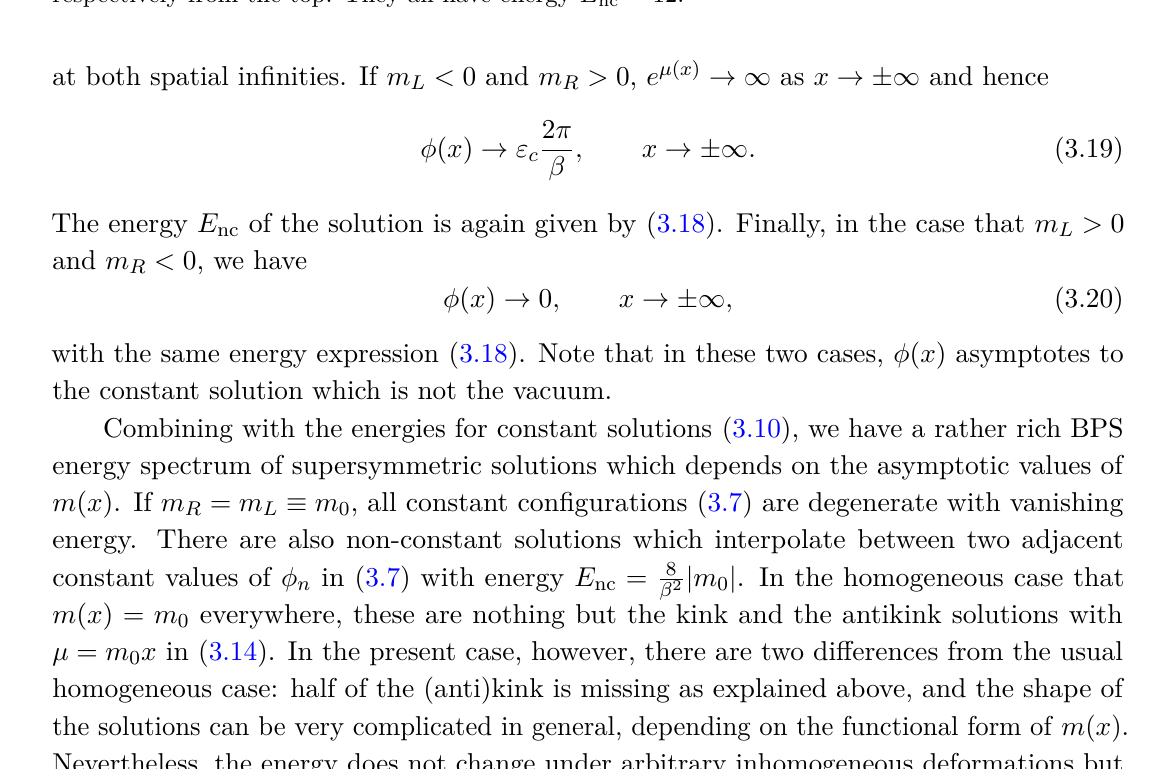
Figure 1 . Supersymmetric solutions of deformed SSG theory for m ( x ) in (3.17) with β = a = 1 . (a) m L = 2 and m R = 1 . The vacuum is the dashed straight line φ = 0 (mod 4 π ) with energy E = − 4 . The other constant solution φ = 2 π (mod 4 π ) has energy E = 4 . Non-constant (anti)kink-like solutions are for c = 100 , 10 , 1 , 0 . 1 , 0 . 01 , − 0 . 01 , − 0 . 1 , − 1 , − 10 , and − 100 , respectively from the top. They all have energy E = 2 . (b) m = − 1 and m = 2 . The vacuum is the dashed nc L R straight line φ = 0 (mod 4 π ) with energy E = − 12 . The other constant solution φ = 2 π (mod 4 π ) has energy E = 12 . Nonconstant solutions are for c = 10 , 1 , 0 . 1 , 0 . 01 , − 0 . 01 , − 0 . 1 , − 1 and − 10 , respectively from the top. They all have energy E = 12 nc